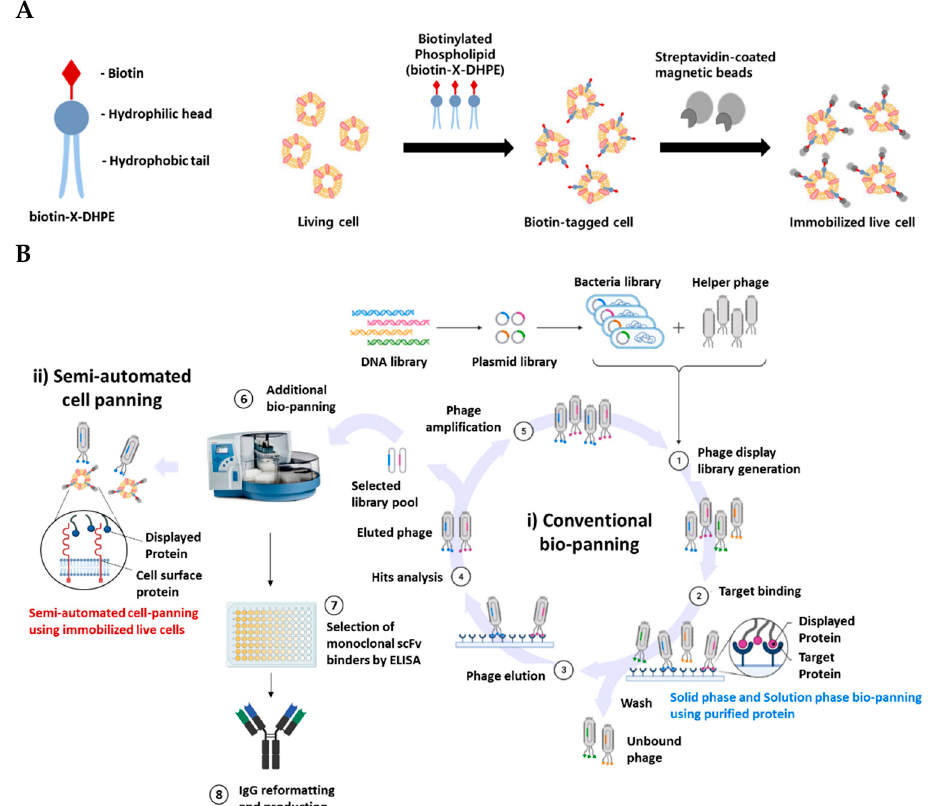
Figure 1. ( A ) Scheme for attachment of magnetic beads to live cells for applying bio-panning. Biotin- X-DHPE, a biotin tagged material, is a cell membrane-like substance composed of a hydrophilic head and a hydrophobic tail. Biotin-X-DHPE reacted with Streptavidin-coated magnetic beads to form a complex that is attached to the surface of living cells. ( B ) Bio-panning workflow combined with semi-automated cell panning. Binding to the rescued phage pool and target protein (Step 1–2). Wash to remove non-binding phage and then elute and amplify phage that binds to target protein (Step 3–5). Phage pool that recognizes naive target protein is isolated and screened by performing semi-automated cell panning on target-expressing cells (Step 6–8). Images created using BioRender.